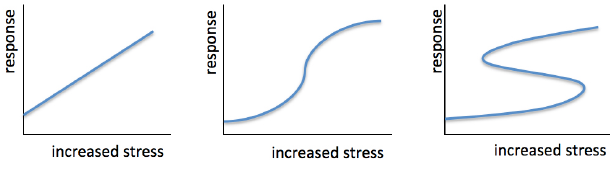
Fig. 2. Types of transitions observed in natural systems (based on Scheffer